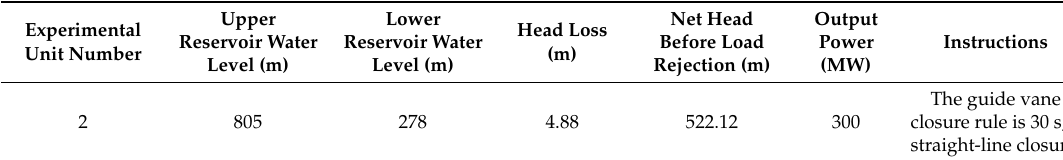
Table 3. Description of field test conditions.